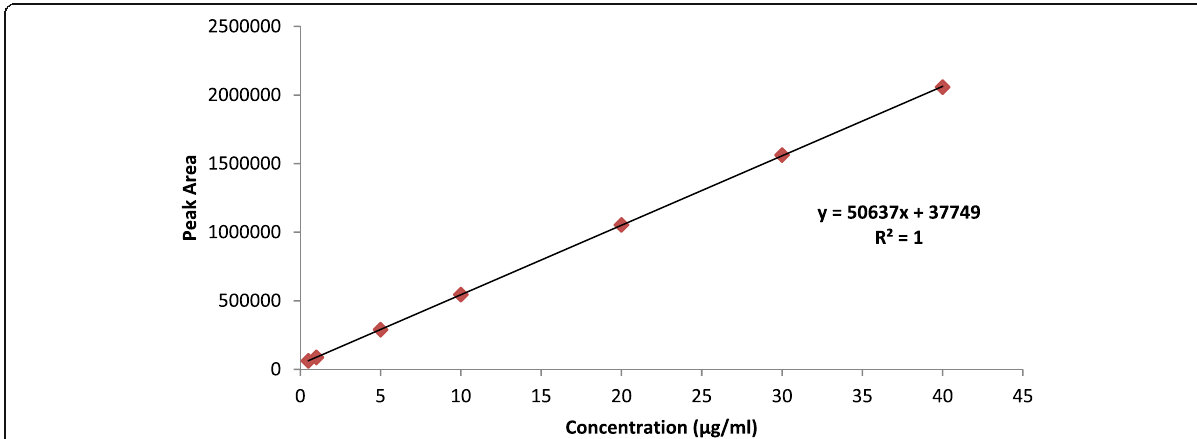
Fig. 5 Calibration plot of naringenin in methanol using methanol and 0.5% ortho-phosphoric acid in MilliQ water as mobile phase in the ratio of (70:30). The chromatogram was detected at 289 nm and the analysis was performed at 30 °C (column oven temperature), with a flow rate of 1 ml/min and injection volume of 20 μ l. The range of the calibration curve was 0.5 μ g/ml to 40 μ g/ml